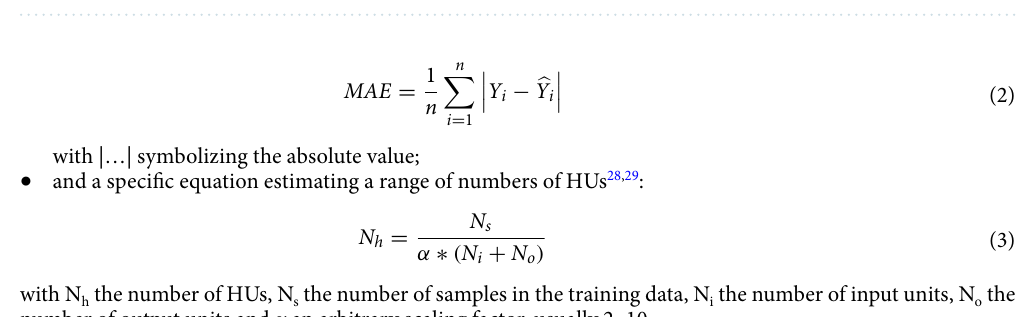
Figure 2. Study workflow. Moreno-Sanchez et al. methodology 8 is represented in orange, whereas the methodology proposed here is represented in yellow. Boxes with a thick line indicate the experimental data used in this study; left box: the flux mentioned here refers to pathway flux titration by changing enzyme activities. The last boxes are the techniques used for a better understanding of the metabolic pathway. The five final models designed in this work are colored in black, white or grey. a See “ Complex Pathway SImulator (COPASI) metabolic networks ”